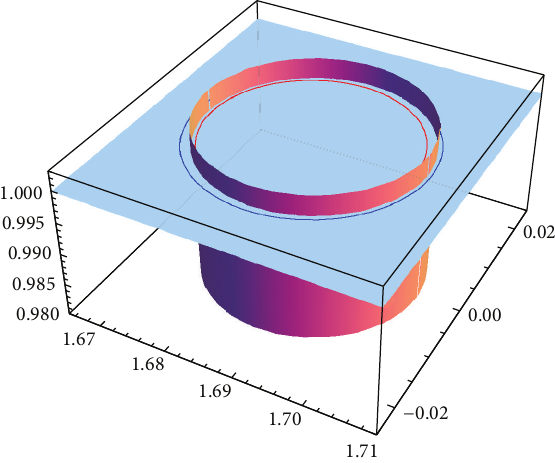
Figure 9: Corona delimited by the circles (𝐶 1 ,𝐶 2 )